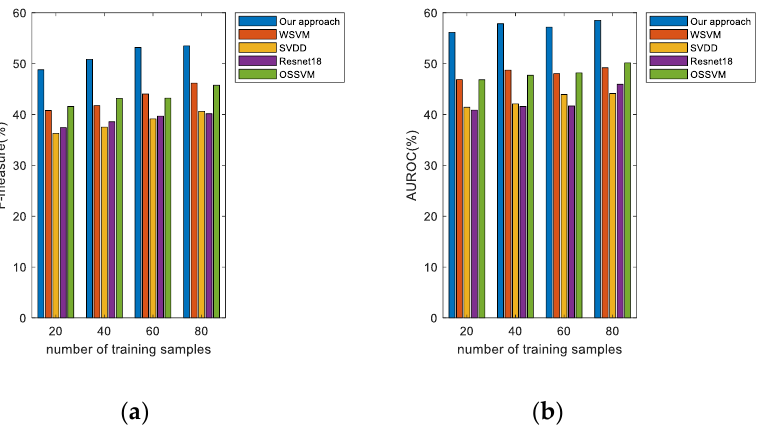
Figure 9. AUROC and F1-measure, when openness equals 0.48, for open-set multi-class recognition using different numbers of training samples on Caltech256 open dataset: ( a ) F1-measure and ( b ) AUROC.